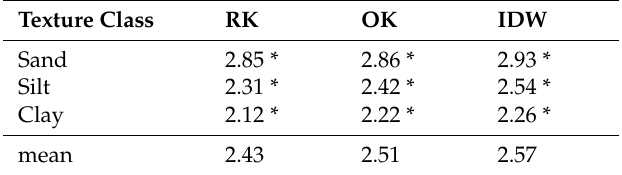
Figure 10. Spatial interpolated soil map for the texture class clay based on the RK approach. Circles display the sample locations and colors are scaled in the same color as background clay map. Table 4. Root mean square error (RMSE) [Mass-%] for retrieved soil texture classes using the different approaches compared to in-situ data. RK: Regression Kriging, OK: Ordinary Kriging, IDW: Inverse Distance Weighted, * denotes a significant difference of the soil texture distributions from the